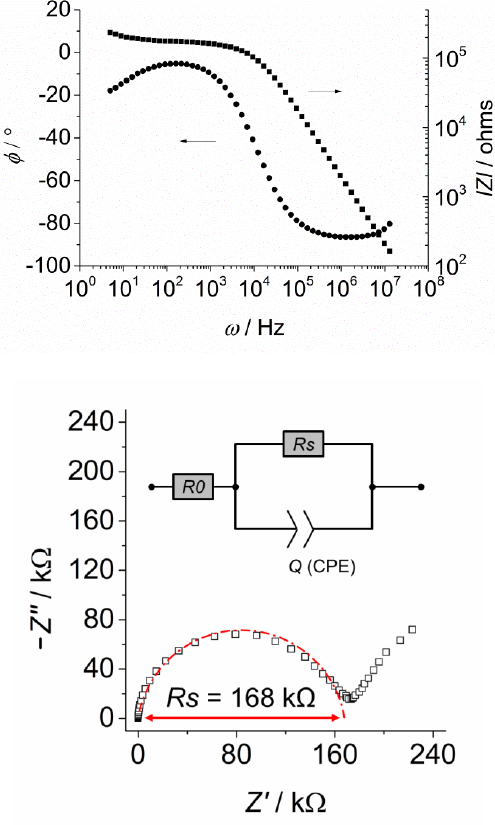
Figure 11. Bode plot showing the frequency dependence of the total impedance |𝑍|(𝜔) and the phase angle 𝜙(𝜔) (top) and the Nyquist plot −𝑍 ′′ (𝑍 ′ ) (imaginary part vs. real part of the impedance) showing a slightly depressed semicircle that was fitted by the equivalent circuit shown in the inlet (bottom).